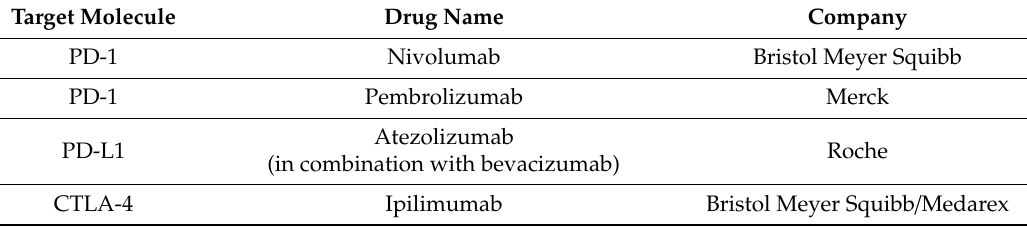
Table 1. Currently approved immunotherapy in hepatocellular carcinoma (HCC) Target Molecule Drug Name Company PD-1 Nivolumab PD-1